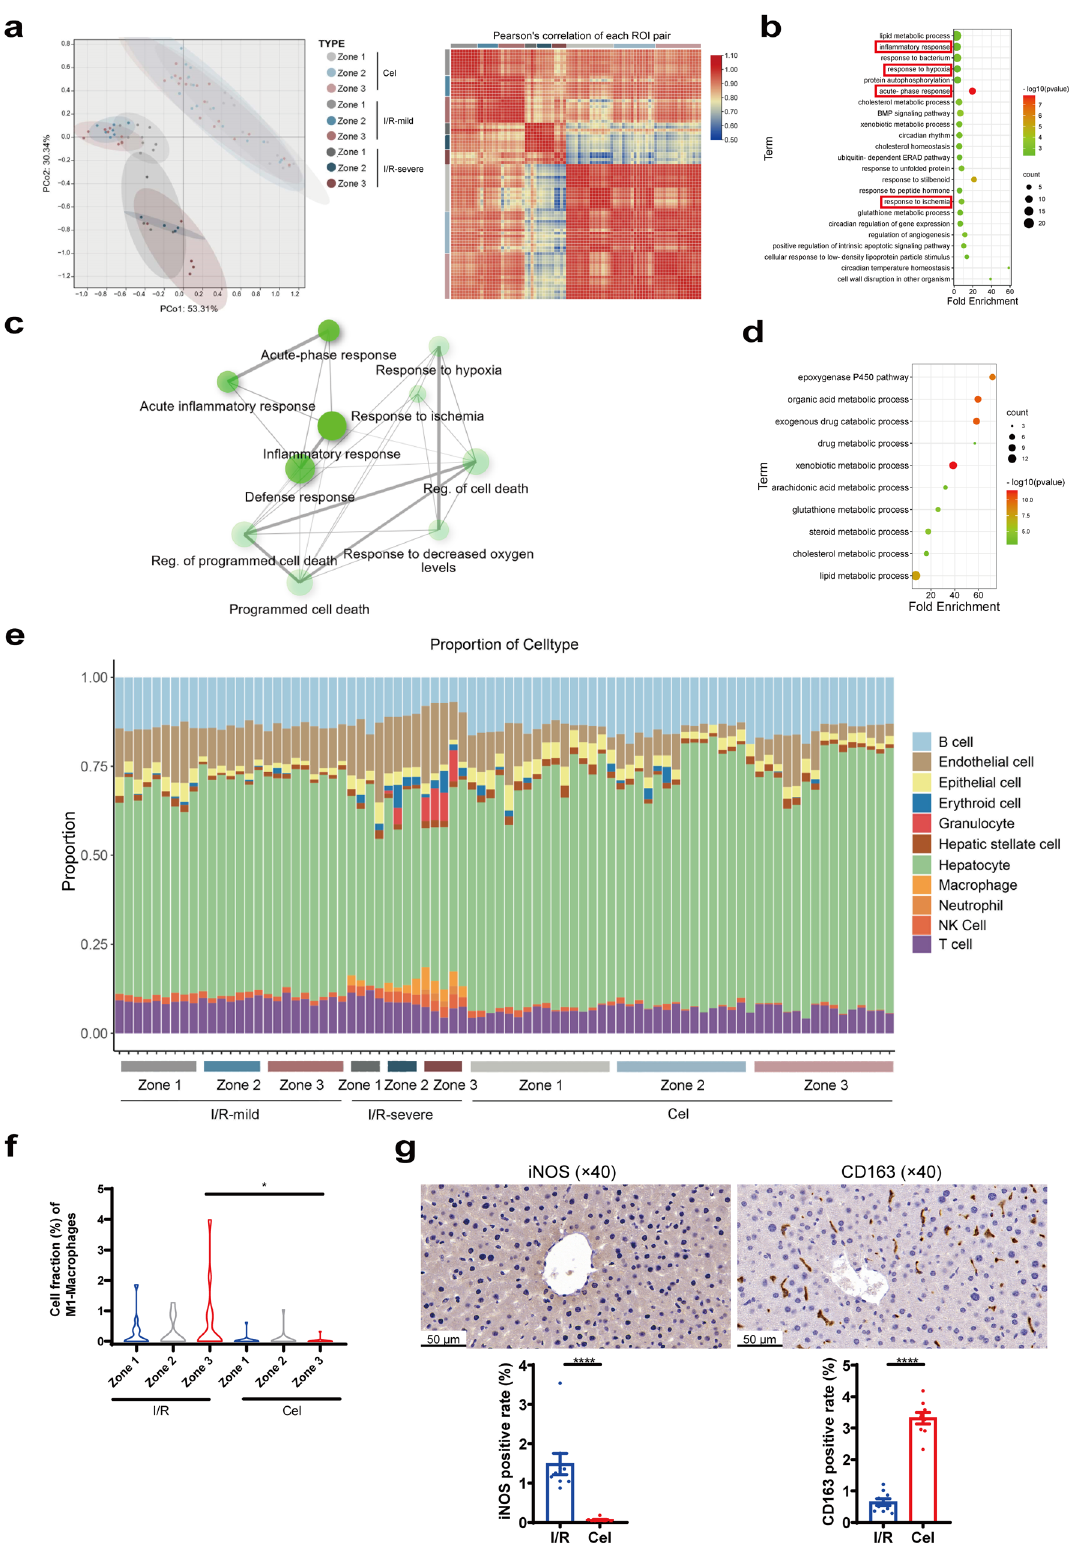
Fig. 6 Spatial transcriptomics analysis of celastrol-regulated gene expression and functional pathways. a PCA and ROI correlation heatmap of I/R and celastrol group. b GO analysis of DEGs of the celastrol group and the I/R group. c Network of pathways highlighted in ( b ). d GO analysis of zone 3-speci fi c DEGs of the celastrol group. e Effect of celastrol on I/R-induced alterations in the proportion of hepatocytes and hepatic NPCs. f Cell fraction of M1- macrophages of I/R and celastrol group (Student ’ s t-test, n = 11 – 16, * p < 0.05). g IHC staining and quanti fi cation of M1-macrophages marker iNOS and M2- macrophages marker CD163 of celastrol group (Student ’ s t-test, n = 9, **** p <